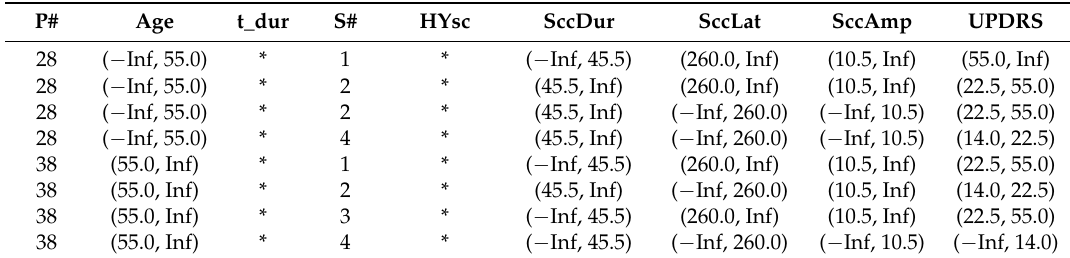
Table 2. Part of the decision discretized-table.